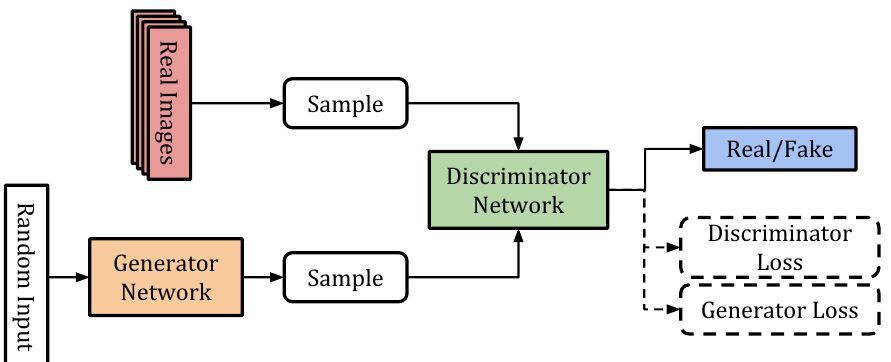
Figure 11. Overview of the Generative Adversarial Network architecture.